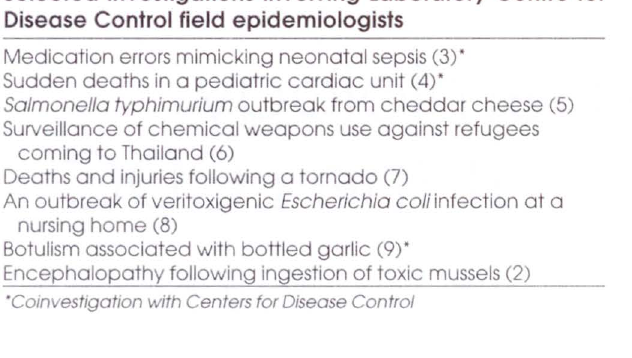
Selected investigations involving laboratory Centre for Disease Control field